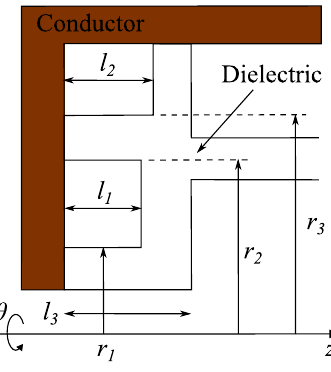
FIG. 7. Longitudinal cross section of the end